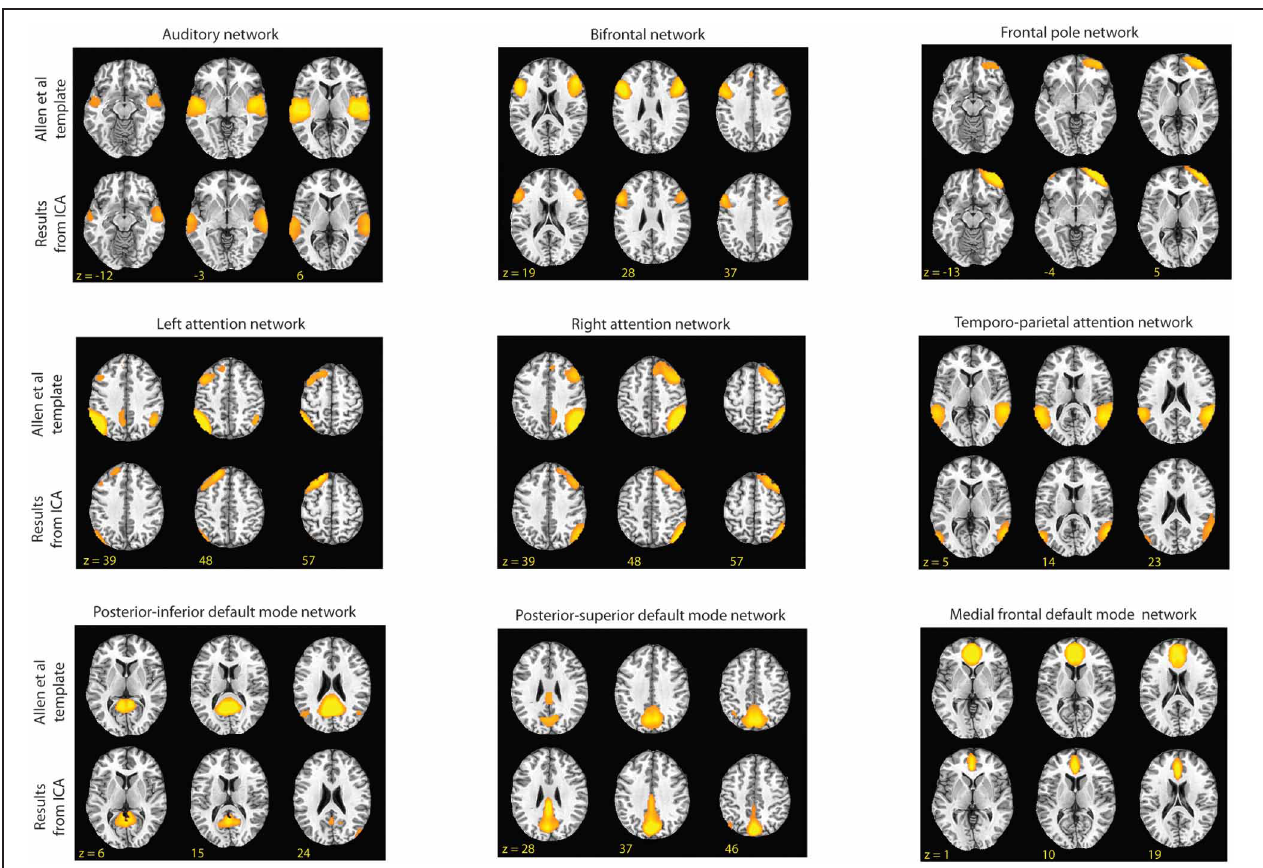
FIGURE 2 | Shown above are the RSNs identified by Allen et al. and the component from our group ICA that had the highest spatial correlation to the Allen et al. templates (2011). In this figure, for the templates the threshold is set at t = 45 and for the matching components from our data the threshold is set at z = 3 .